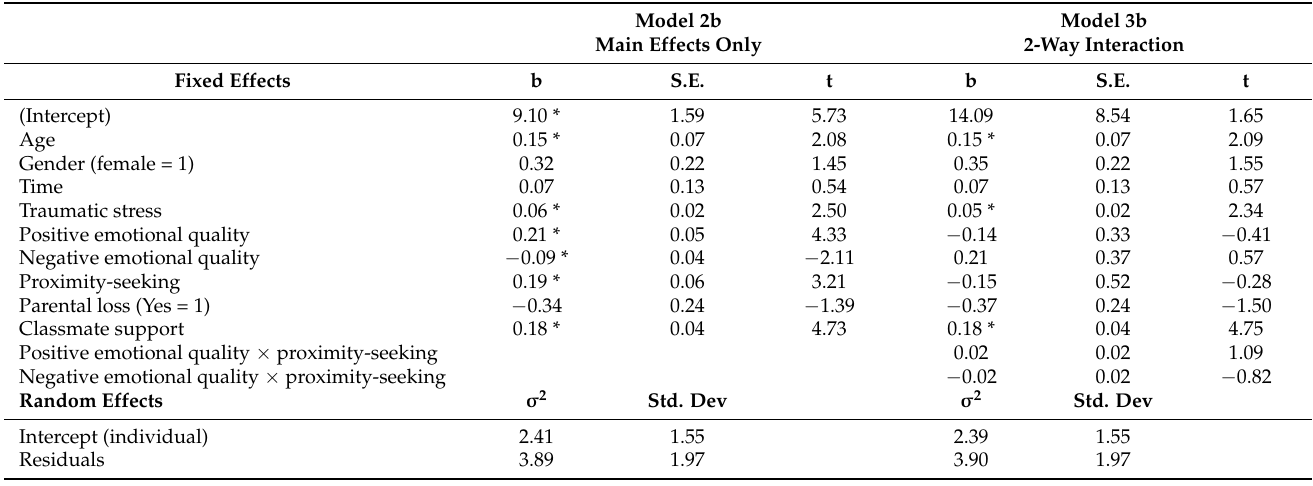
Table 5. Coefficients for factors affecting ethnic identity commitment ( n = 544).